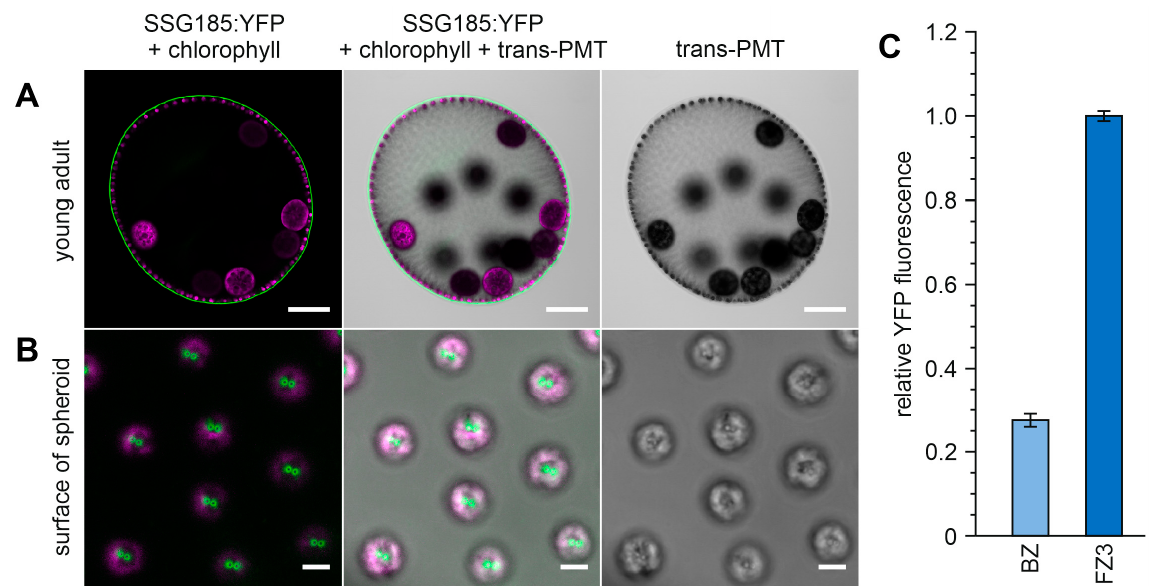
Figure 7. Localization of SSG185:YFP at the surface of young adult V. carteri spheroids. Transformants expressing the ssg185 : yfp gene under the control of the endogenous ssg185 promoter were analyzed in vivo for the localization and fluorescence intensity of the SSG185:YFP fusion protein. ( A ) CLSM optical cross-section of a young adult spheroid with mature gonidia shortly before the first cell division. Note that the continuous layer of SSG185:YFP at the surface of the spheroid shows increased fluorescence right above each somatic cell. Scale bars: 100 μ m. ( B ) High-magnification CLSM top view onto the surface of the spheroid. Note that the two fluorescent spots above each somatic cell have a non-fluorescent center, which corresponds to the position of the flagella. Due to the viewing direction and CLSM settings, weaker fluorescence on the entire surface (as shown in the cross-section in A) cannot be observed here. Scale bars: 5 μ m. ( A , B ) Column 1: Overlay of YFP fluorescence of SSG185:YFP protein (green) and chlorophyll fluorescence (magenta). Column 2: Overlay of SSG185:YFP fluorescence (green), chlorophyll fluorescence (magenta) and transmission-PMT (trans-PMT). Column 3: Transmission-PMT alone. ( C ) To measure fluorescence intensity, it was quantified in the YFP channel (520–550 nm) in a straight line spanning through the BZ or FZ3, respectively, and the maximal value was recorded. The recorded intensity values were normalized to the highest recorded value in order to exclude the influence of differing laser intensities between the replicates. The data represent three biological replicates with three technical replicates each. Error bars indicate standard deviation of the mean of the three biological replicates.